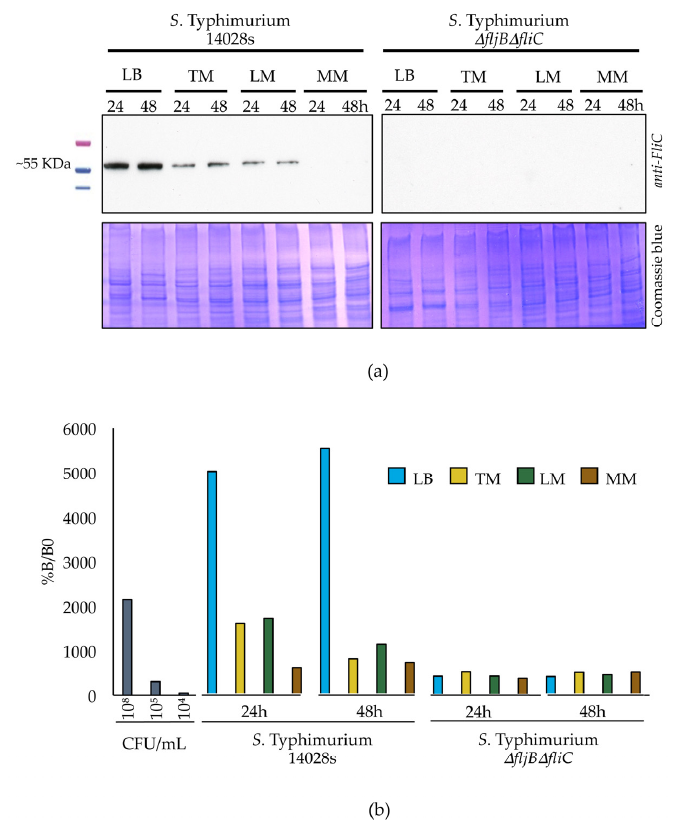
Figure 4. Flagellin synthesis is reduced in plant-based media. Presence of flagellin protein was determined using western blot ( a ) and ELISA ( b ) techniques. Total Salmonella proteins were extracted 24 or 48 h after inoculation of S. Typhimurium 14028s into LM, TM, MM or LB media. Inoculation with the S. Typhimurium ∆ fljB ∆ fliC mutant was used as a negative control. Five µ g of total protein was separated on SDS–PAGE and blotted on a PVDF membrane prior to probing with a primary anti- Salmonella specific flagellin ( anti-FliC ) antibody, followed by probing with secondary anti-mouse antibody coupled to HRP enzyme and exposition ( a ). Alternatively, 96-well plates were coated with proteins isolated as indicated and probed with primary ( anti-FliC ) and secondary anti-mouse antibody coupled to HRP antibodies. The resulting substrate production was assessed 30 min after reaction start using 450 nm and 652 nm wavelengths. As internal control, several dilutions of the wild type strain growing in LB at 24 hpi were used to compare the expression level. The dilutions used were 10 8 , 10 5 , and 10 4 CFU\mL ( b ).